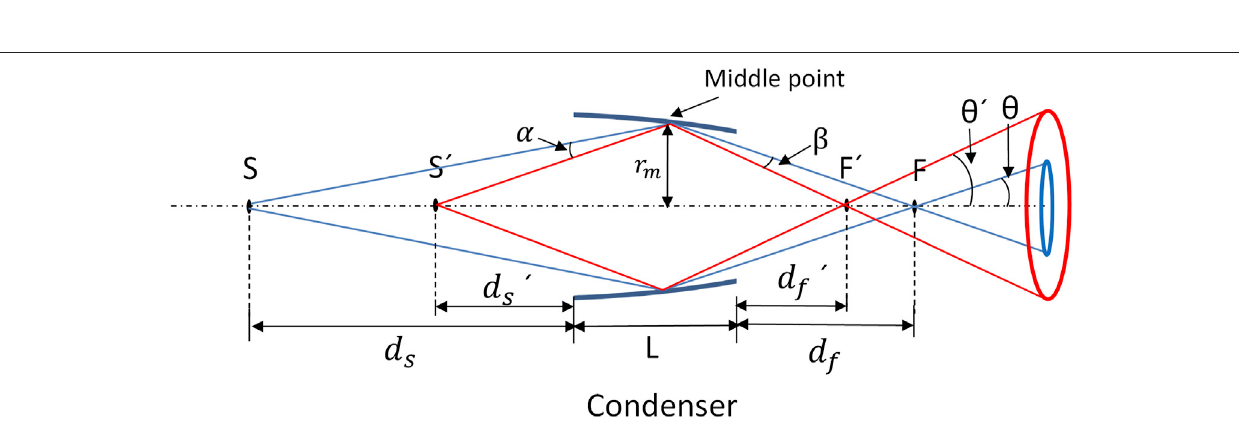
FIGURE 5 | Geometric sketch of the x-ray source deviating from the input focal spot of the ellipsoidal MXRL as a condenser for TXM (the blue line represents the transmitting lightfrom the x-ray source totheinputfocalspotofthe condenser,and the red linerepresentsthe transmitting lightfrom the x-ray source deviating from the input focal